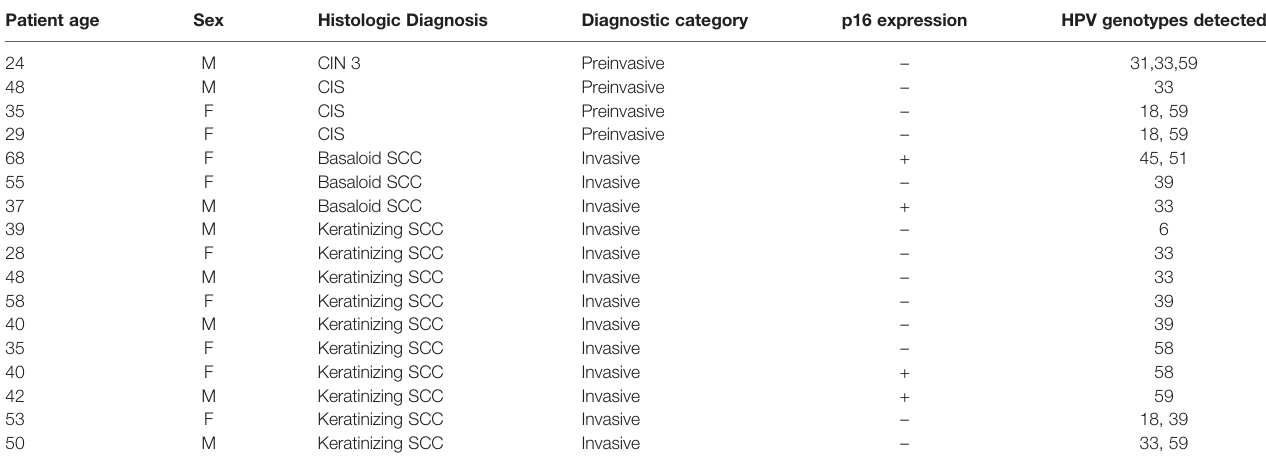
TABLE 5 | HPV genotypes detected in tumors by PCR and associated p16 results by diagnostic category. Patient